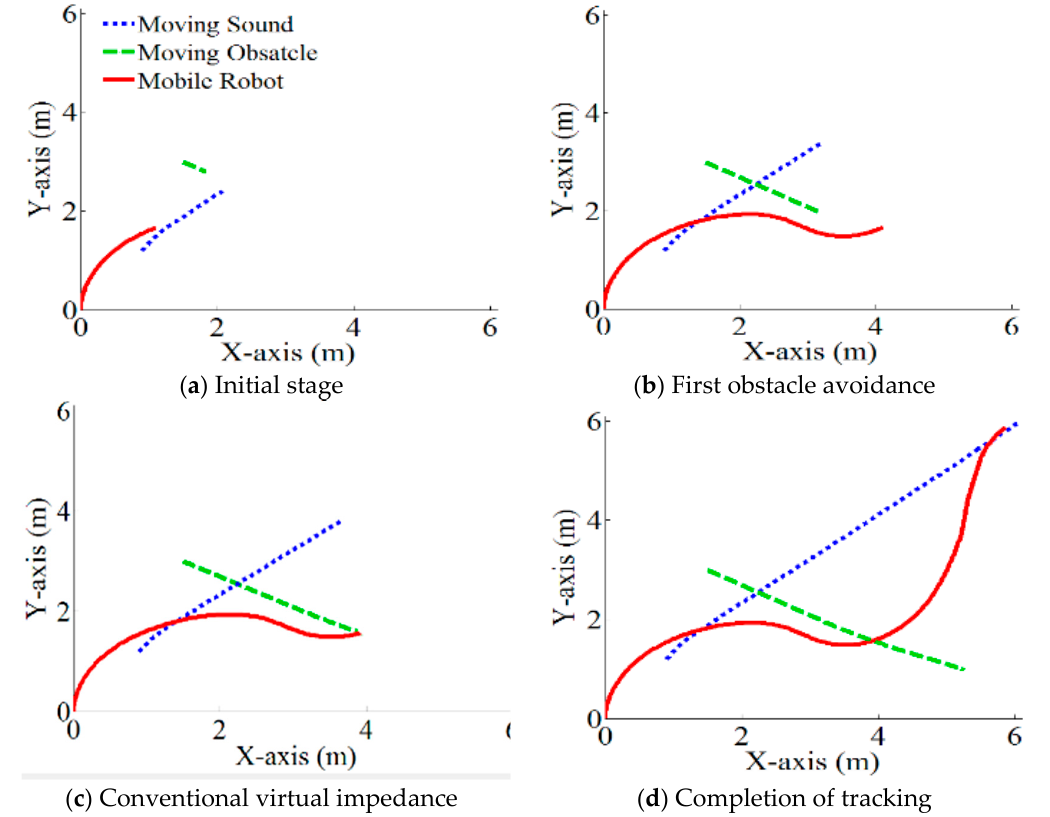
Figure 15. ( a ),( b ),( d ) The successful tracking of the sound source by the mobile robot using the active virtual impedance; ( c ) the collision situation when the conventional virtual impedance algorithm was used for tracking.